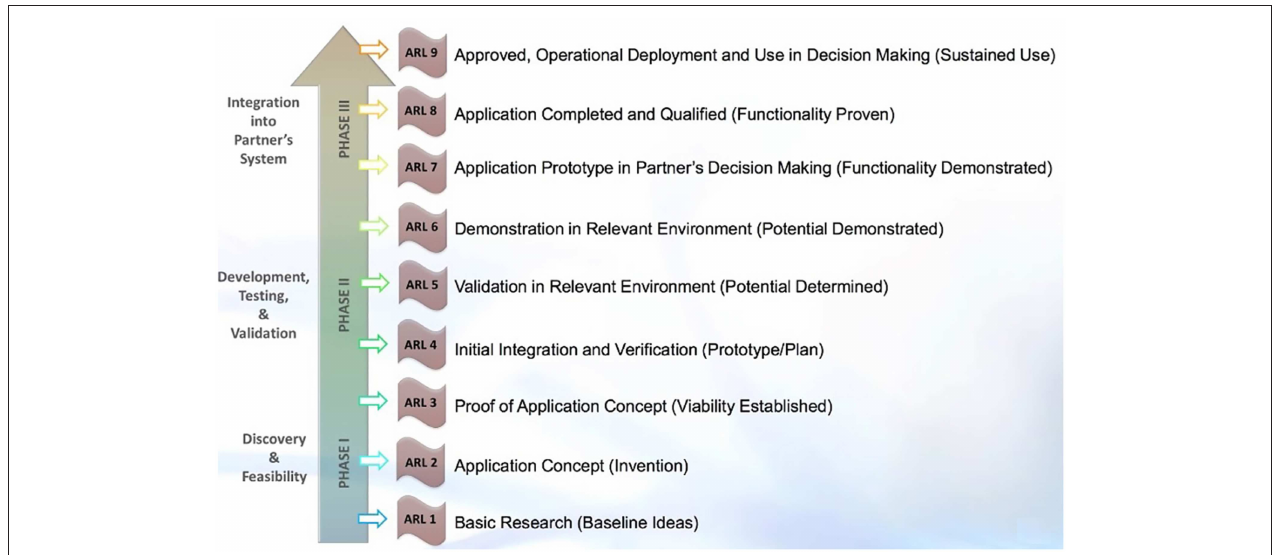
FIGURE 1 | NASA application readiness level scale. Available online at: https://www.nasa.gov/sites/default/files/files/ExpandedARLDefinitions4813.pdf (accessed September 20,